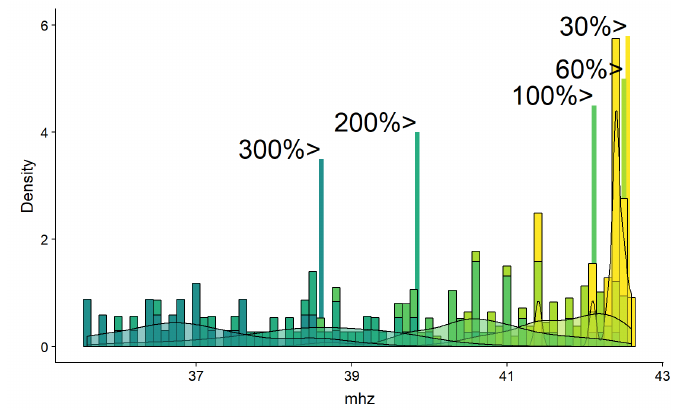
Figure A1. Distributions of the data underlying the categories reported in Table 1. The categories are denoted as vertical lines above. As freq (MHz) has an inverse relationship with moisture content, higher-moisture samples occur on the left of the graph (darker green). The lines denote the point where 95% of freq values within a category occur to the left of the line, and thus, sample moisture content is at most the denoted value to the right of each line. although there is some error associated with the 95% cut-off.